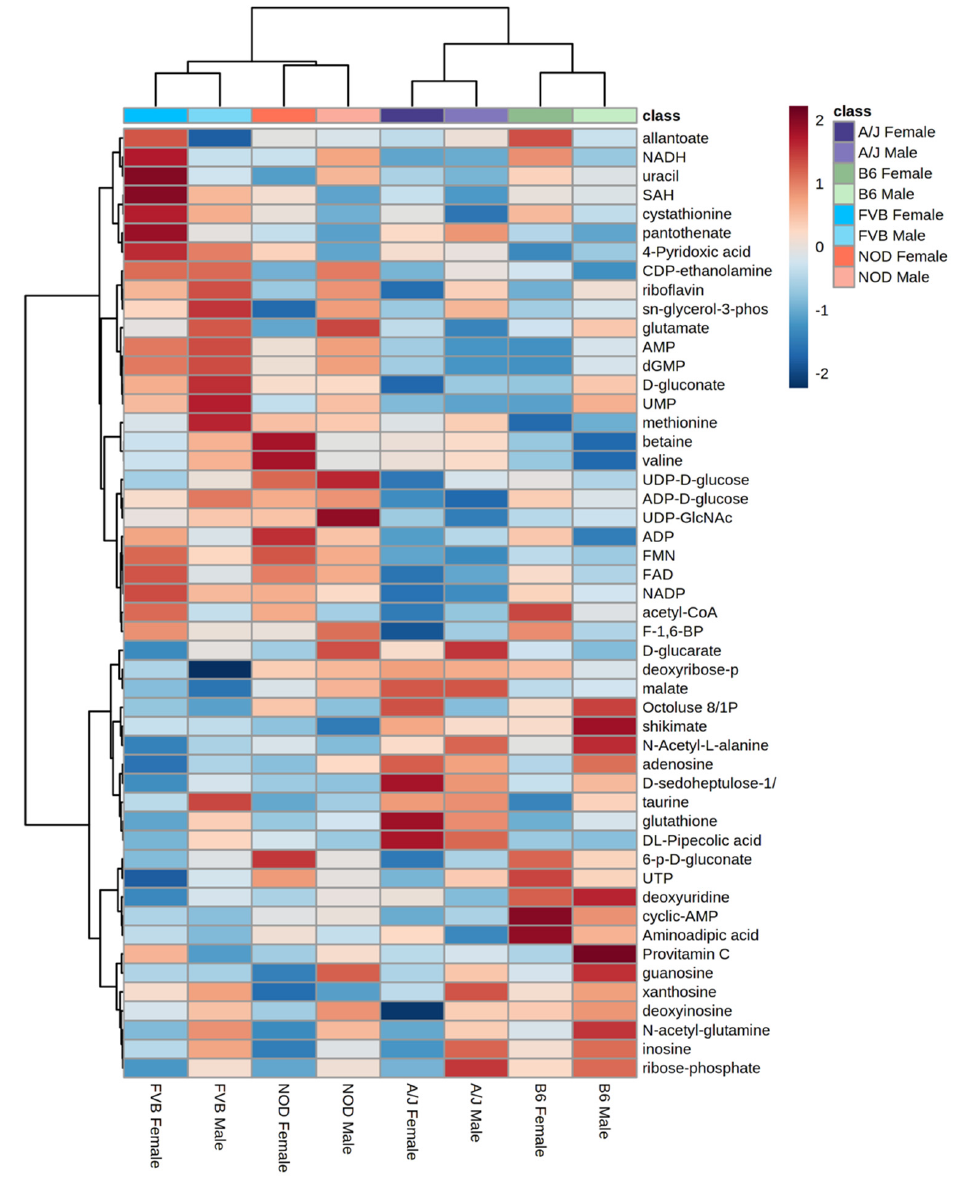
Figure 3. Hierarchical clustering by sex and strain based on metabolite abundance in liver. Heatmaps were generated in Metaboanalyst (v.5.0) using peak abundances of all metabolites. Hier- archical clustering was performed on group averages using Pearson distance and Ward clustering; scale is based on Z-score.